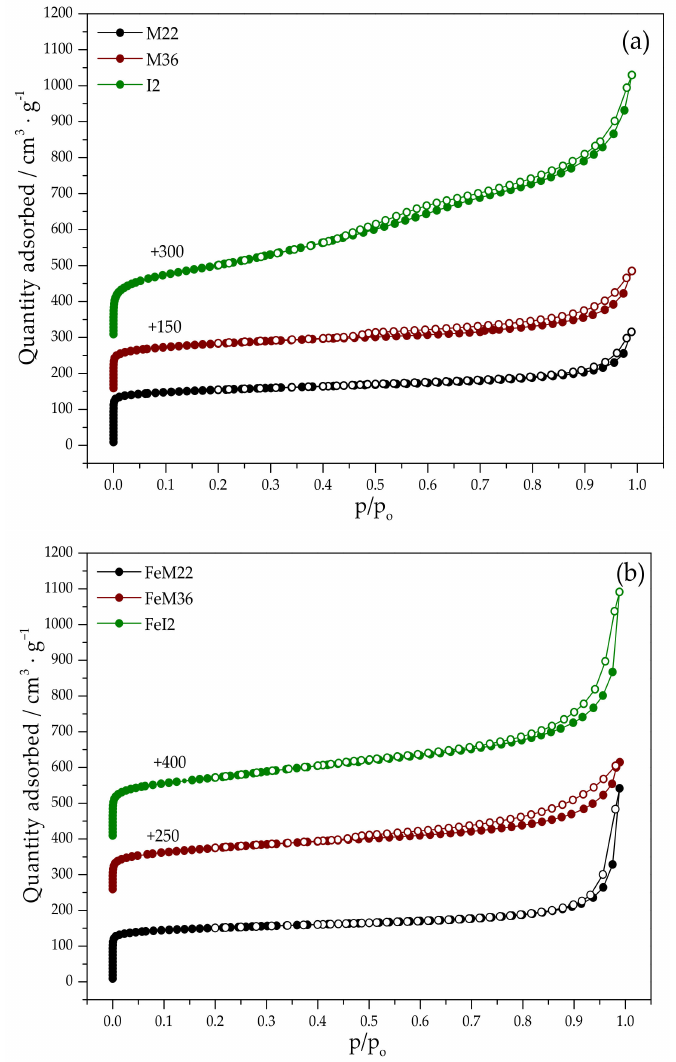
Figure 2. N 2 sorption isotherms obtained for the investigated materials: ( a ) pristine MWW zeolites; ( b ) iron-modified MWW